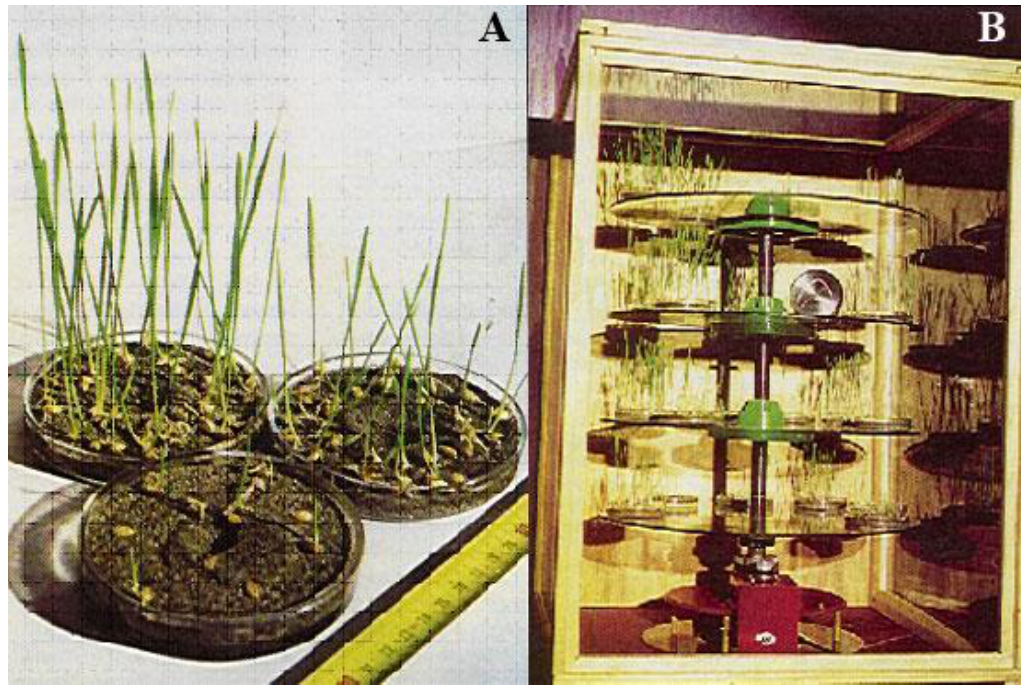
FIGURE 1 . Wheat germination model. (A) Seeds placed on sterilized sand in Petri dishes; (B) Petri dishes randomly distributed in a germination